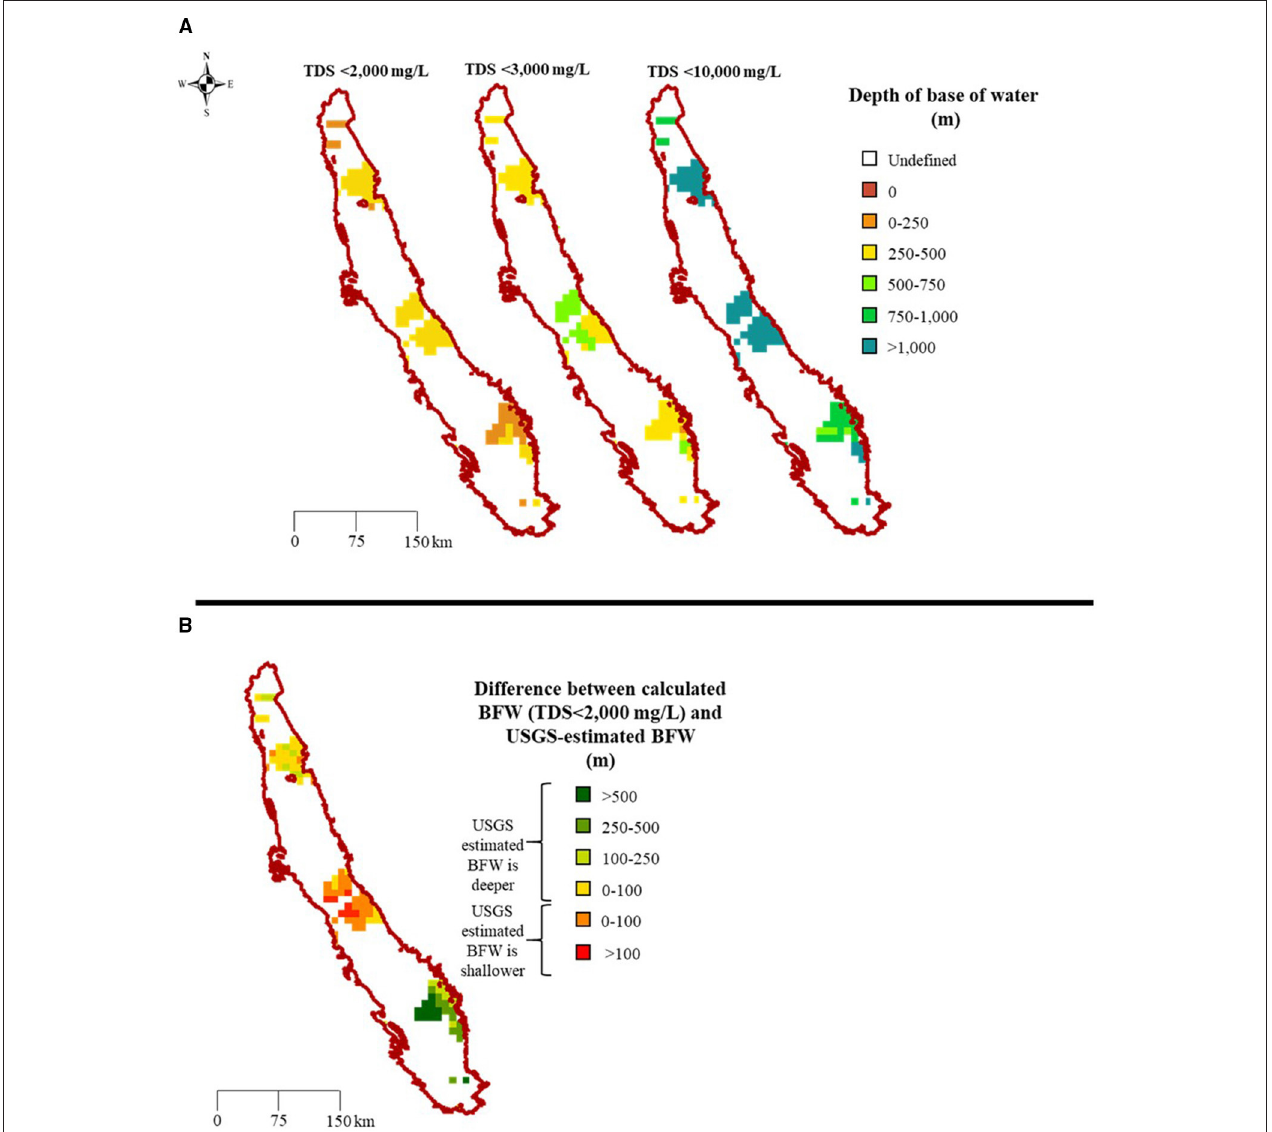
FIGURE 2 | Maps of the base of water (A) using TDS < 2,000 mg/L (left), TDS < 3,000 mg/L (center), and TDS < 10,000 mg/L (right). Differences between the USGS-estimated BFW and our estimated BFW using TDS < 2,000 mg/L (B) . In (B) , green/yellow areas show where the USGS-estimated BFW is deeper and red/orange areas show where the USGS-estimated BFW is shallower, compared to our BFW estimate using TDS < 2,000 mg/L. (A) Maps of the base of fresh water. (B) Differences between the USGS-estimated BFW and the BFW estimated in this paper using TDS < 2,000 mg/L.